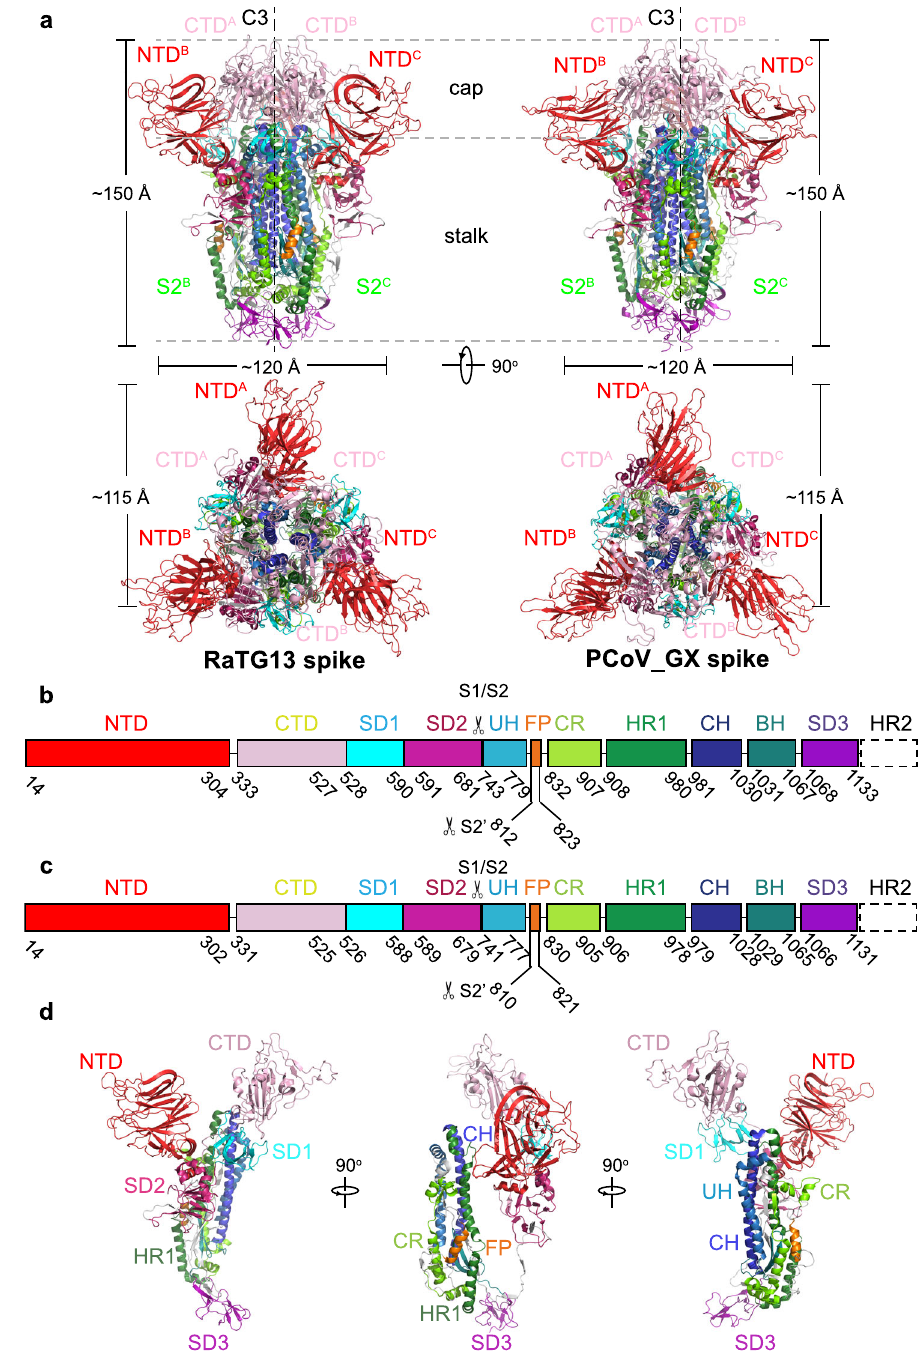
Fig. 1 Overall structures of the RaTG13 and PCoV_GX spike glycoproteins. a Overall structures of the RaTG13 and PCoV_GX spike glycoproteins shown in side view (upper panel) and top view (lower panel). The domains were painted with colors shown in b and c . The trigonal axes are shown as black dashed lines. Visible segments of each monomer are labeled accordingly. The cap and stalk parts are partitioned by gray dashed lines. b Schematic representation of the RaTG13 spike monomer structural domains. The domains of RaTG13 are shown as boxes with the width related to the length of the amino acid sequence. The start and end amino acids of each segment are labeled. The position of the S1/S2 and S2 ’ cleavage sites are indicated by scissors. NTD, N-terminal domain; CTD, C-terminal domain; SD1, subdomain 1; SD2, subdomain 2; UH, upstream helix; FP, fusion peptide; CR, connecting region; HR1, heptad repeat 1; CH, central helix; BH, β -hairpin; SD3, subdomain 3. c Schematic representation of the PCoV_GX spike monomer structural domains. The abbreviations of elements are the same as in b . d Cartoon diagrams depicting three orientations of the spike monomer colored as in b and c . As the RaTG13 and PCoV_GX spike monomers have extremely similar structures, thus only the RaTG13 spike monomer was used to show the detailed